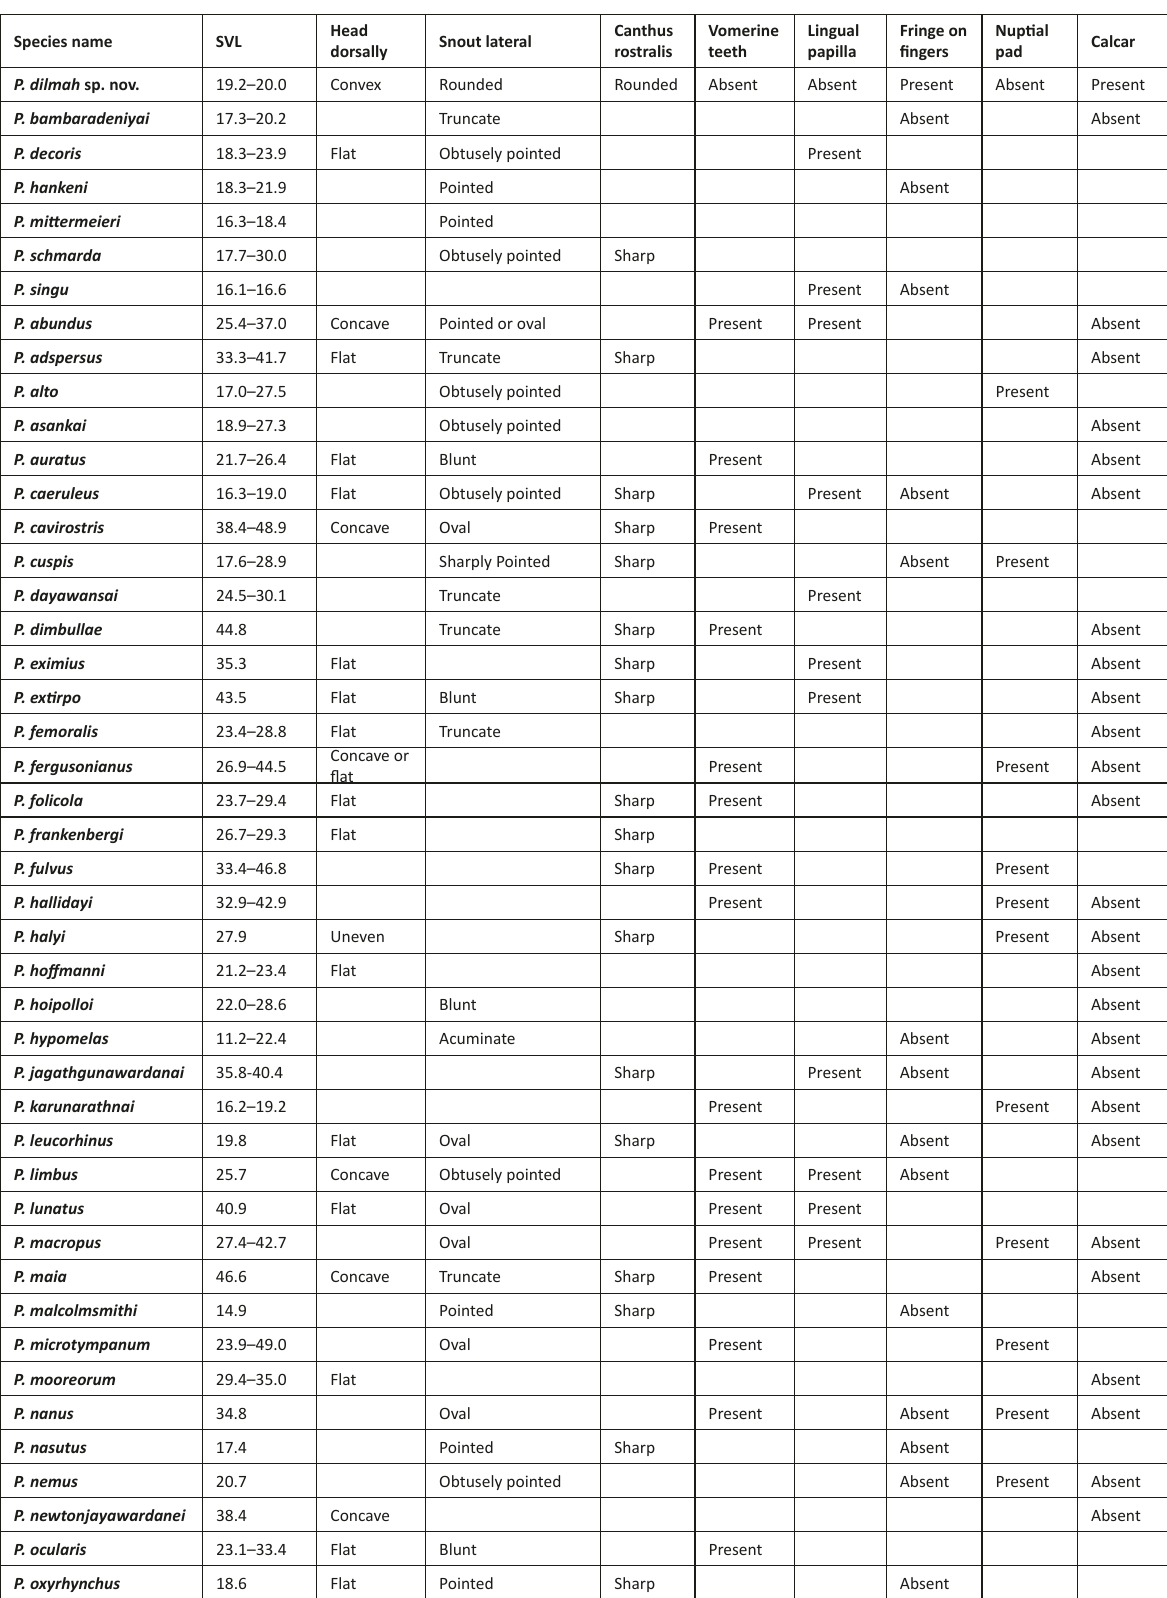
Table 2. Characters that differentiate Pseudophilautus dilmah sp. nov., among congeners of the genus Pseudophilautus. An empty cell in the table denotes either the same character as that of the new species, or for few extinct species when there was no data